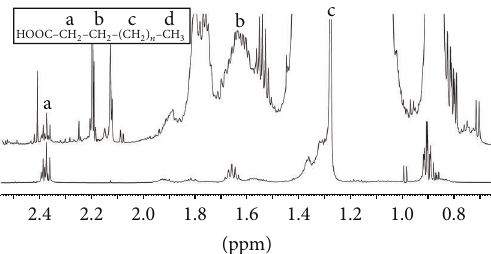
Figure 5: NMR analysis of fatty acids from cell extracts. 1D 1 H NMR spectra of S. solfataricus cell extracts (top trace) and lipid standard (bottom trace). A general chemical formula of a saturated fatty acid is illustrated above the top NMR spectrum, with four types of hydrogen atoms experiencing different chemical environments labelled as a, b, c, and d. The characteristic chemical shifts of these chemically distinct hydrogens are assigned correspondingly to specific NMR signals in the top trace NMR